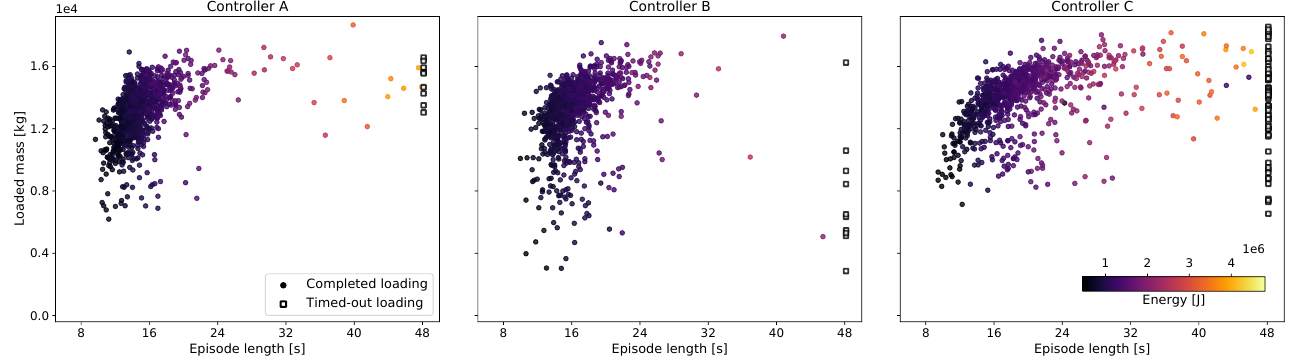
Figure 5. The performance of the three tested controllers over 953 loading